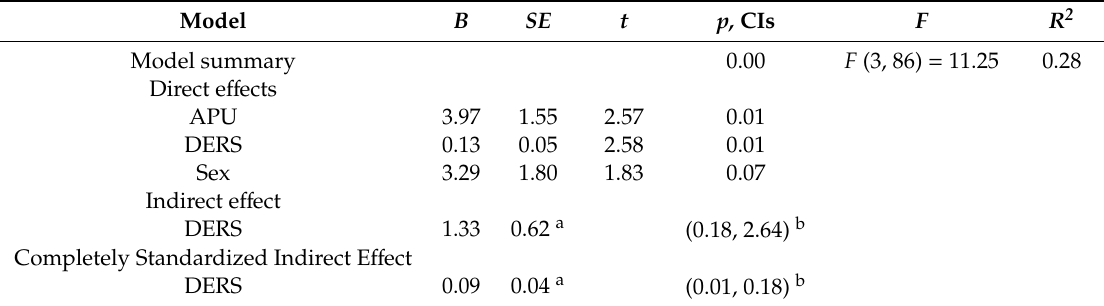
Table 5. Emotion Regulation Di ffi culties (DERS) as a Mediator of the Relation Between Addictive Phone Use (APU) and Food